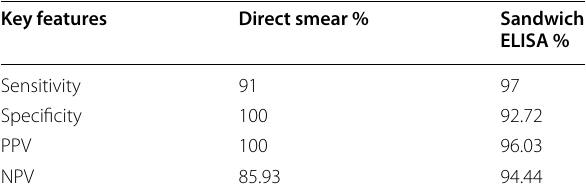
Table 3 The specificity, sensitivity, NPV and PPV of microscopic examination and sandwich ELISA in stool